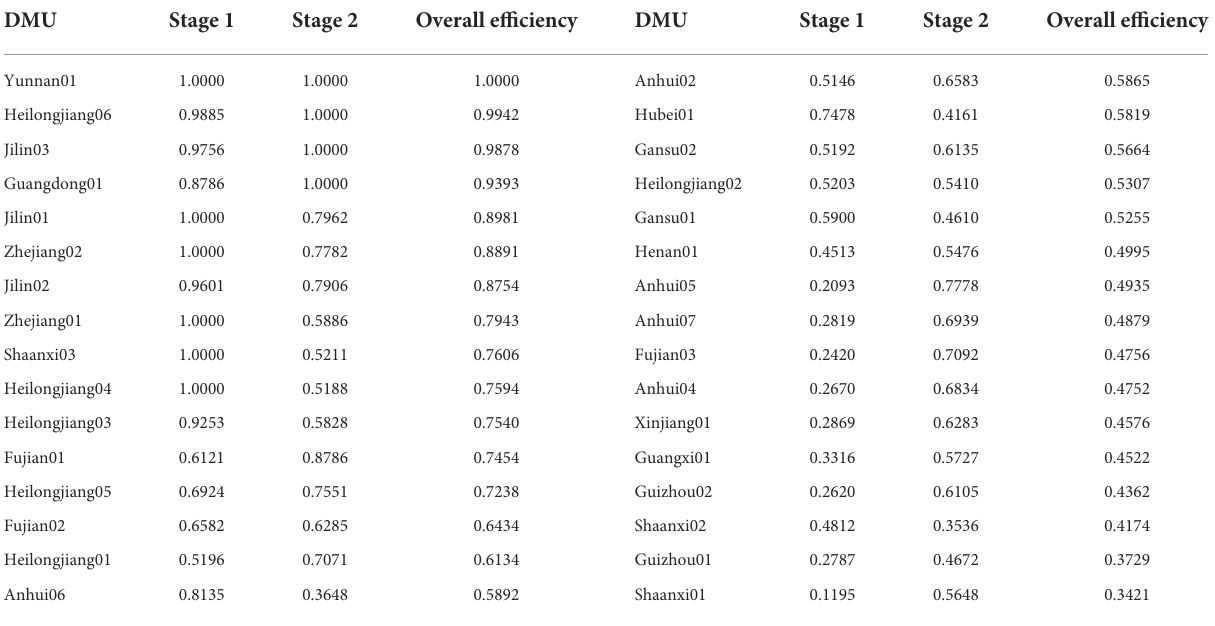
TABLE 2 Overall efficiency and stage-specific efficiency from 2012 to